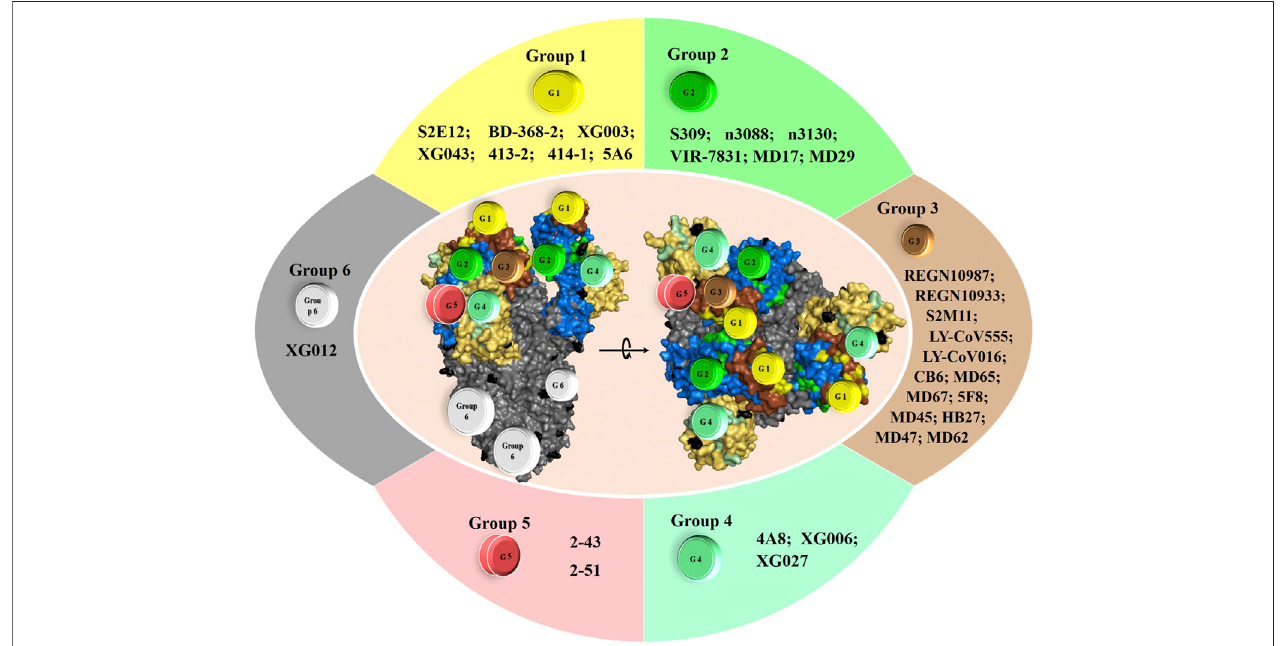
FIGURE4| TopNmAbsinadvancedclinicaltrialphaseIIIandthepotentialNmAbsforef fi cientcocktailformulation.Theneedforpotentialemergencytreatmentfor COVID-19 has birthed a dozen antibodies in clinical trials. The most advanced of them are in clinical trial phase III, and they include: i) REGN10933+REGN10987 (clinicaltrials.gov; ID: NCT04452318), sponsored by Regeneron Pharmaceuticals; ii) LY-CoV555+LY-CoV016 (LY3819253+LY3832479) (clinicaltrials.gov; ID: NCT04427501), sponsored by Eli Lilly and Company of Indianapolis; iii) LY-CoV555 (LY3819253) (clinicaltrials.gov; ID: NCT04497987), sponsored by Eli Lilly and Company of Indianapolis; iv) VIR-7831 (fully NmAb engineered from S309 features) (clinicaltrials.gov; ID: NCT04545060), sponsored by Vir biotechnology and